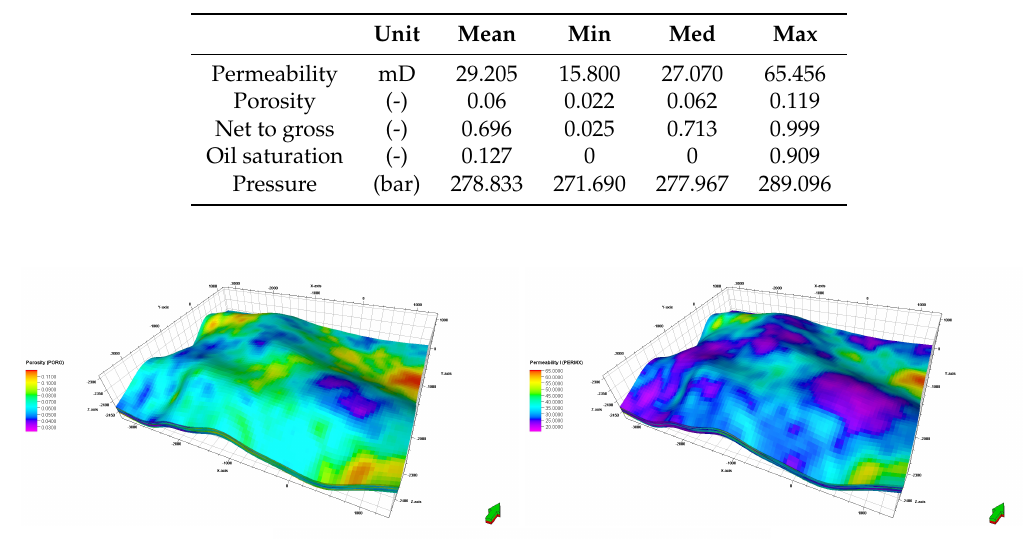
Statistical analysis of the basic petrophysical parameters in the evaluated reservoir. Source: typical values for reservoirs located in the Carpathian area of Poland, internal AGH UST Drilling, Oil and Gas faculty report. Adapted from Janiga et al. [33].